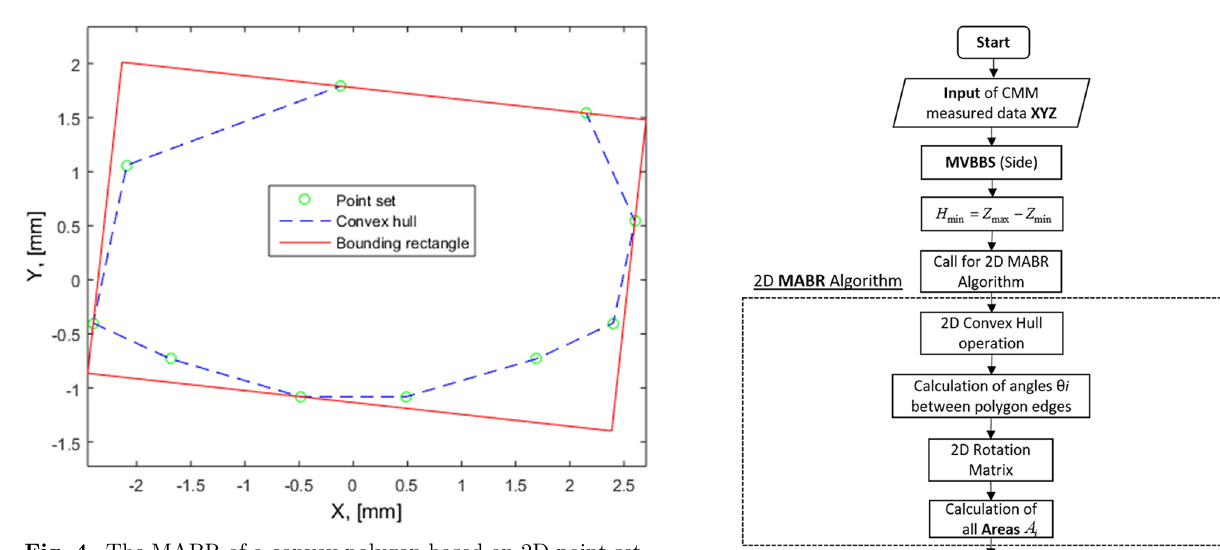
Fig. 4. The MABR of a convex polygon based on 2D point set.